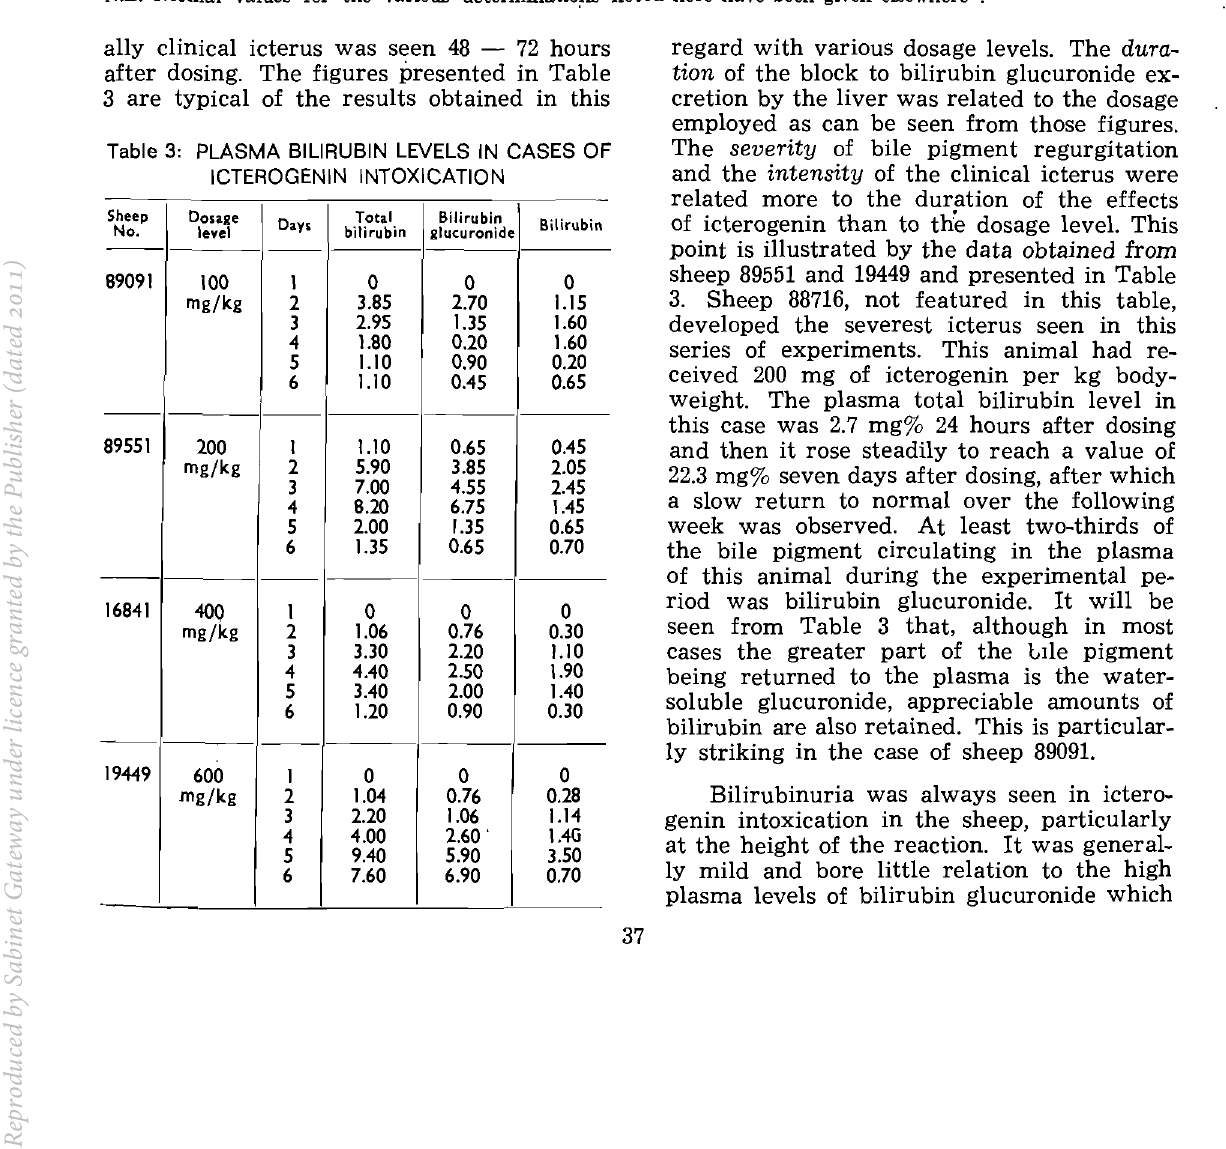
Table 3: PLASMA BILIRUBIN LEVELS IN CASES OF ICTEROGENIN INTOXICATION Sheep Dosage